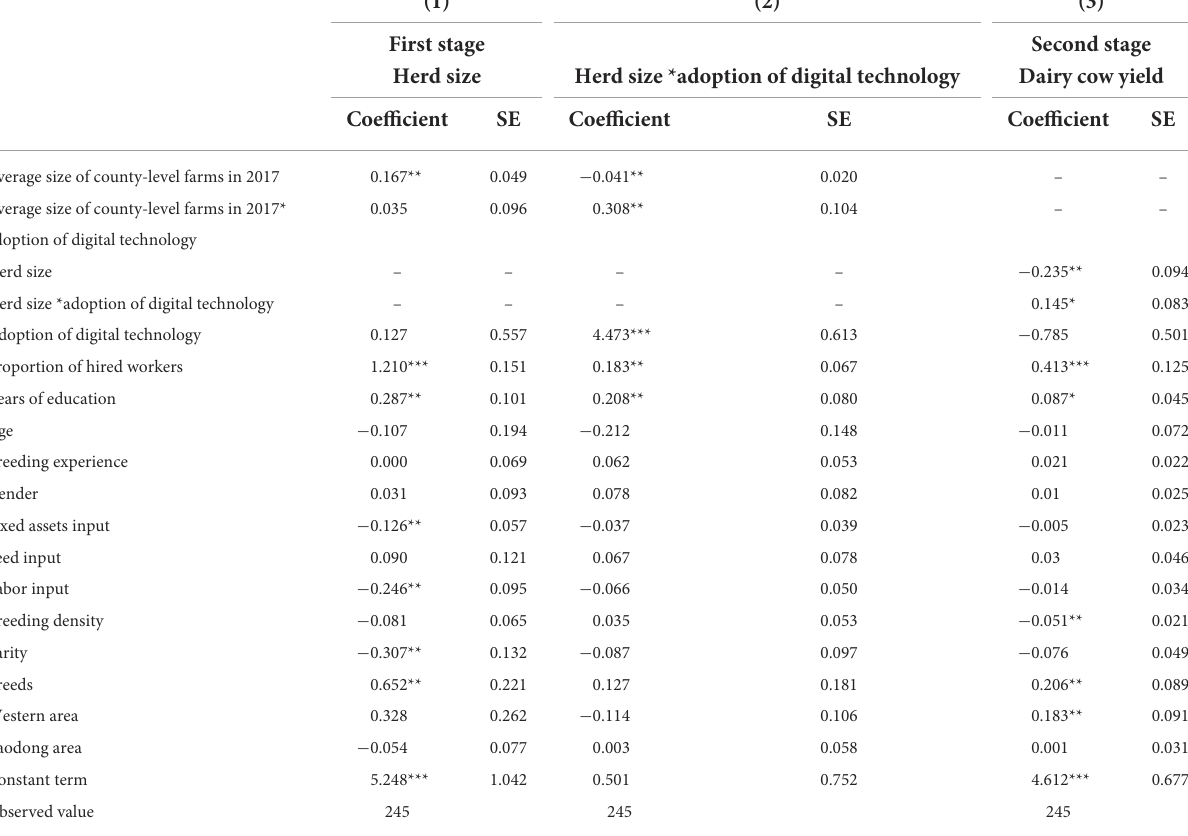
TABLE 6 Robustness test: the impact of digital technology adoption on the relationship between herd size and dairy cow yield by change the dependent